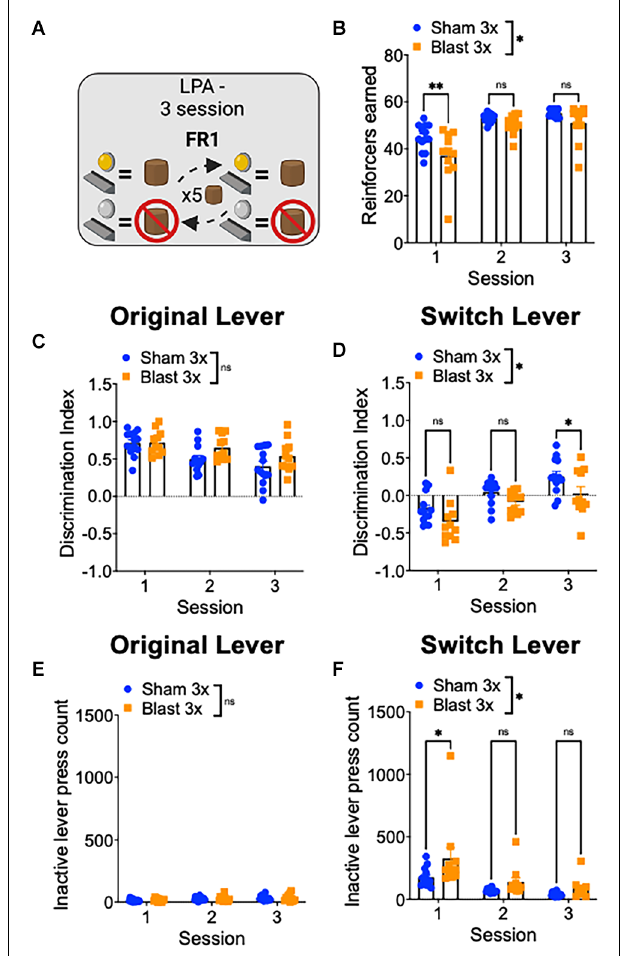
FIGURE 4 | Repetitive blast exposure results in behavioral inflexibility and perseverative-like responding. (A) Lever press alternation (LPA) schematic—lever contingencies switch every five reinforcers obtained. (B) Number of reinforcers earned. (C,D) Discrimination Index (active − inactive/active+inactive) on original (C) and switch (D) trials. (E,F) Number of inactive lever presses on original (E) and switch (F) trials. Two-way RM ANOVA Bonferroni-Šídák post hoc (A–F) . ∗ p ≤ 0.05, ∗∗ p ≤ 0.01, ns, not significant. Values represent mean ±